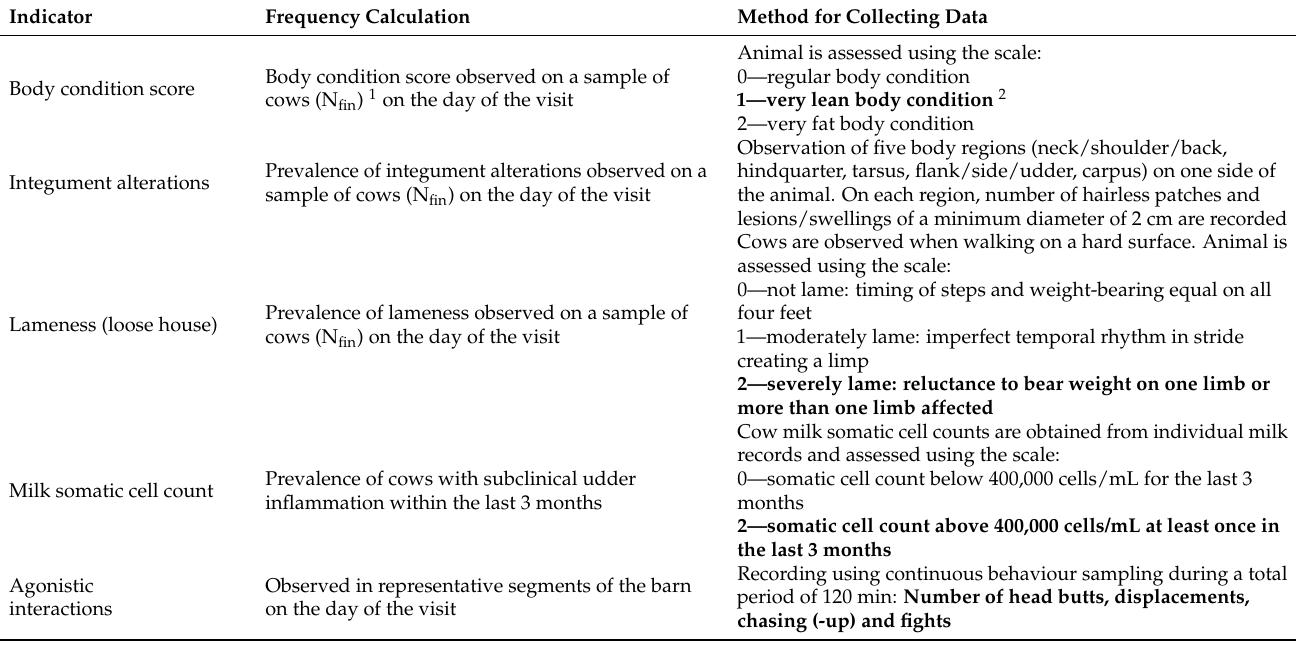
Table 2. Data collected for the assessment of the animal welfare level of lactating dairy cows using the Welfare Quality ® protocol for dairy cattle (modified after Coignard et al.